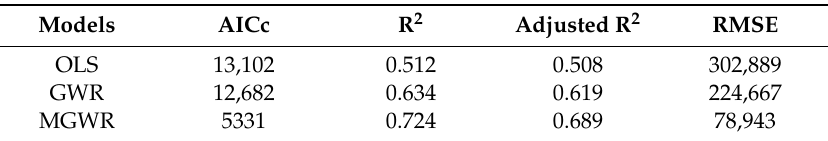
Table 4. Comparison between MGWR, GWR, and OLS